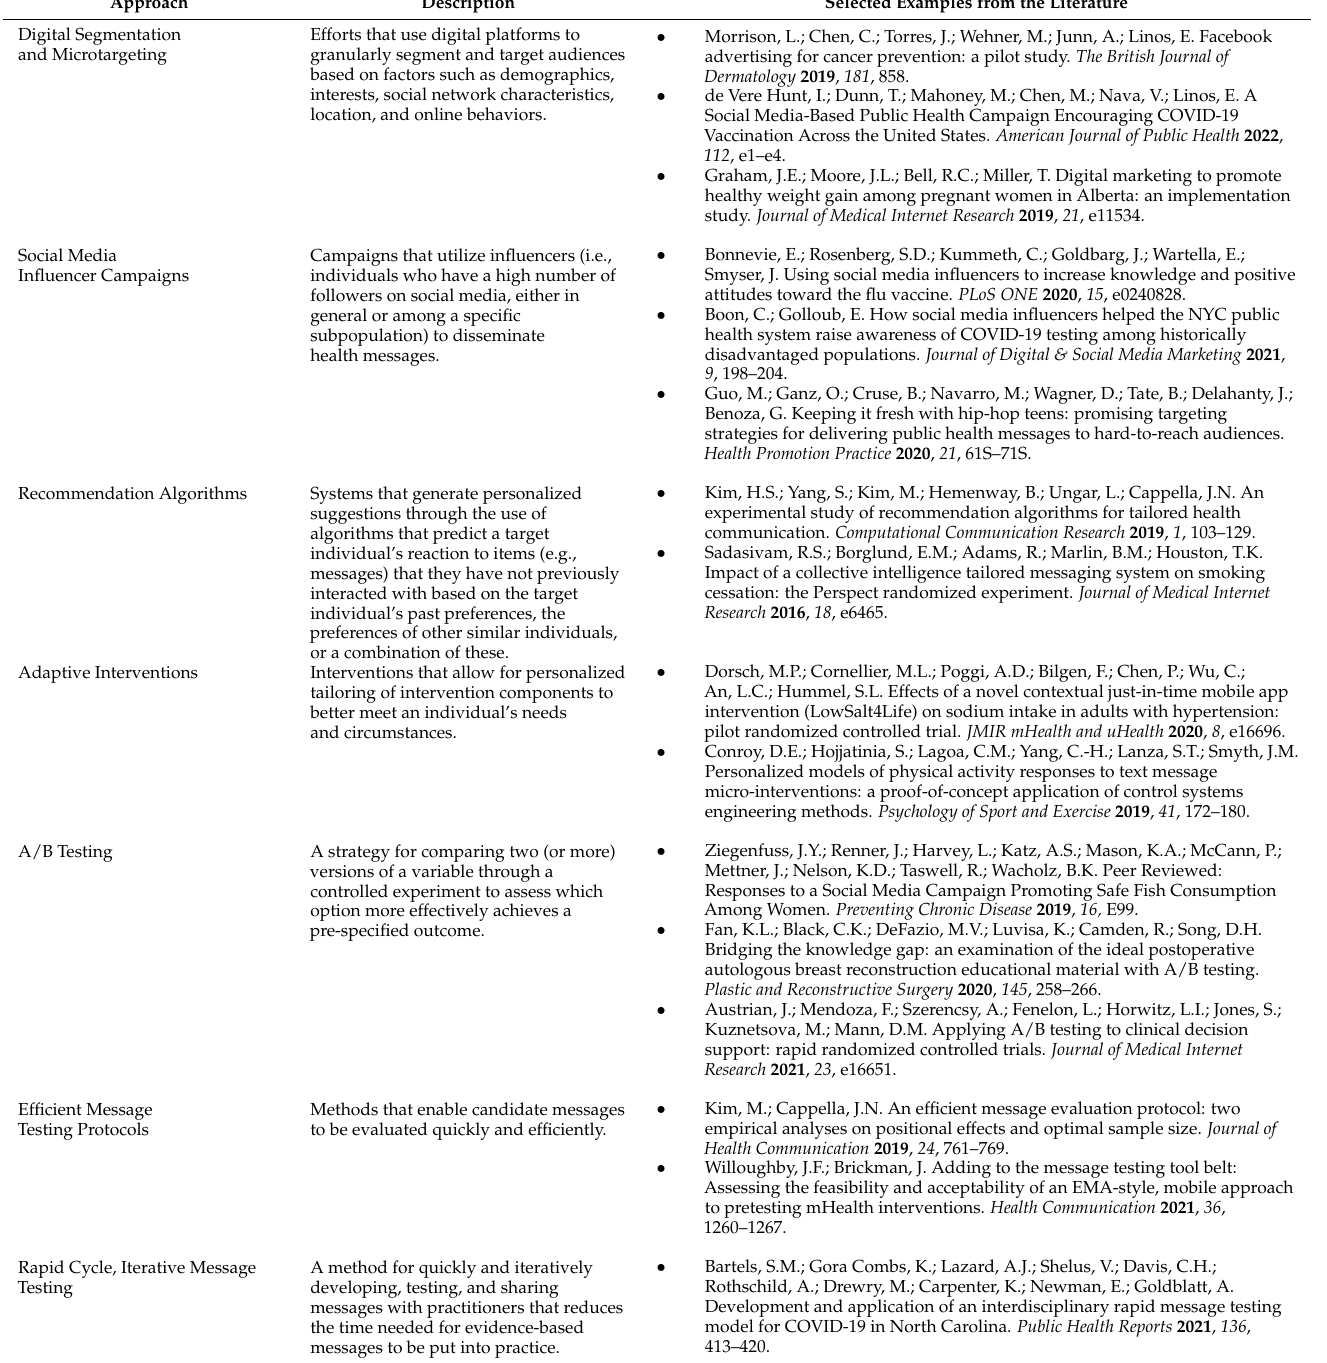
Table 1. Innovative health communication approaches and selected examples of studies leveraging these